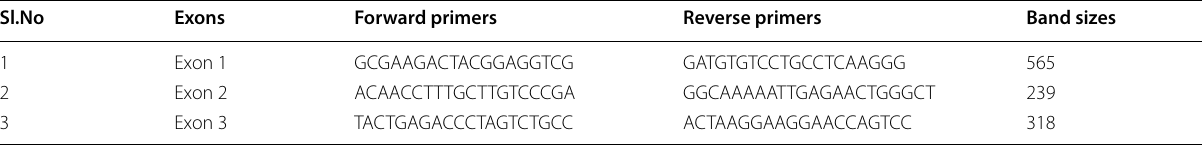
Table 1 Primers for VHL (NM_000551)